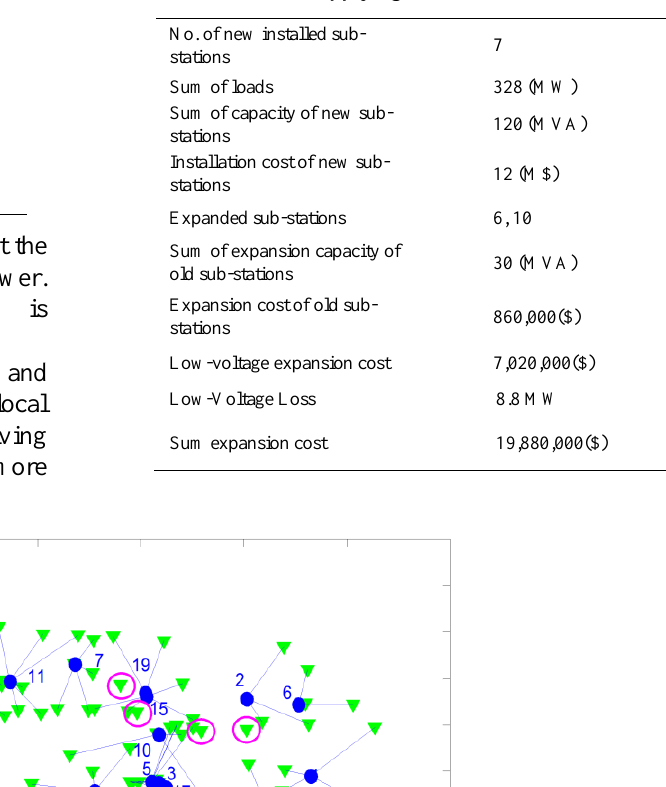
Table 4. Results of applying GA to a Real